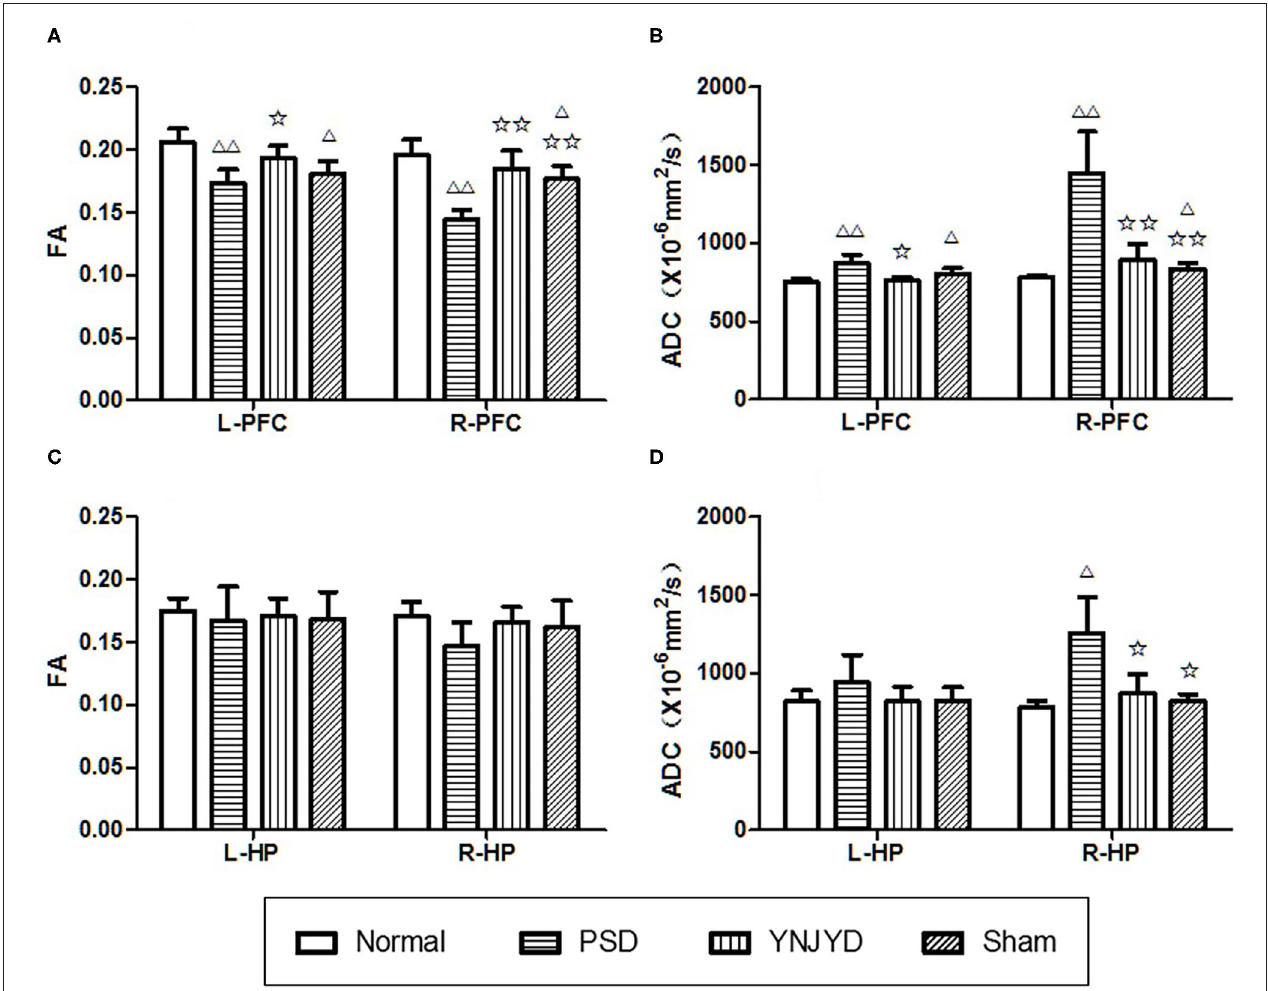
FIGURE 6 | Effects of yi-nao-jie-yu decoction (YNJYD) administration on changes in fractional anisotropy (FA) and apparent diffusion coefficient (ADC) levels. (A) FA level in the bilateral prefrontal cortex (PFC). (B) ADC level in the bilateral PFC. (C) FA level in the bilateral hippocampus (HP). (D) ADC level in the bilateral HP. L = left side; R = right side. The data are presented as means ± SD. 1 P < 0.05, 11 P < 0.01 vs. normal; 9 P < 0.05, 99 P < 0.01 vs. PSD (post-stroke depression)